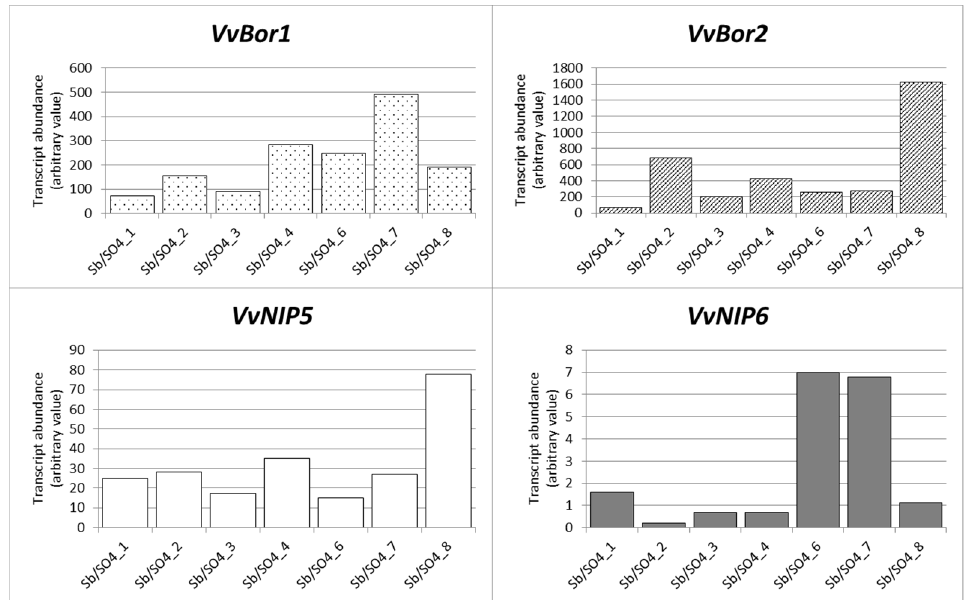
Figure 3. Relative gene expression of four borate uptake and transporter genes (VvBOR1-efflux boron transporter, VvBOR2 -boron transporter, VvNIP5 -efficient boron uptake and plant development under boron limitation, and VvNIP6 -boric acid uptake) in the collected grapevines.